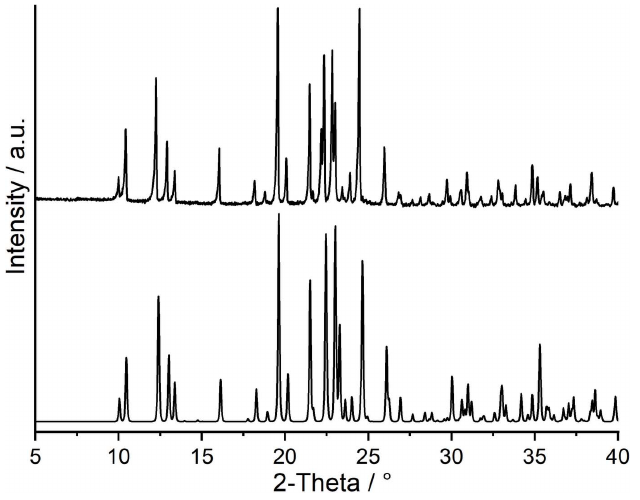
Figure 1 Experimental (top) and calculated PXRD pattern (bottom) of the title